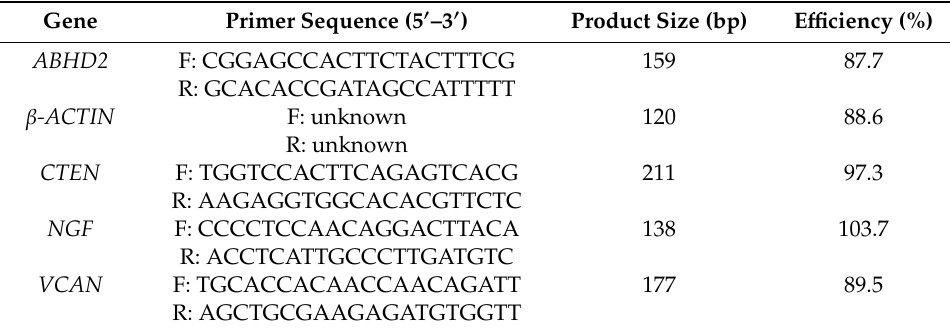
Table 1. Primers used for the quantitative PCR